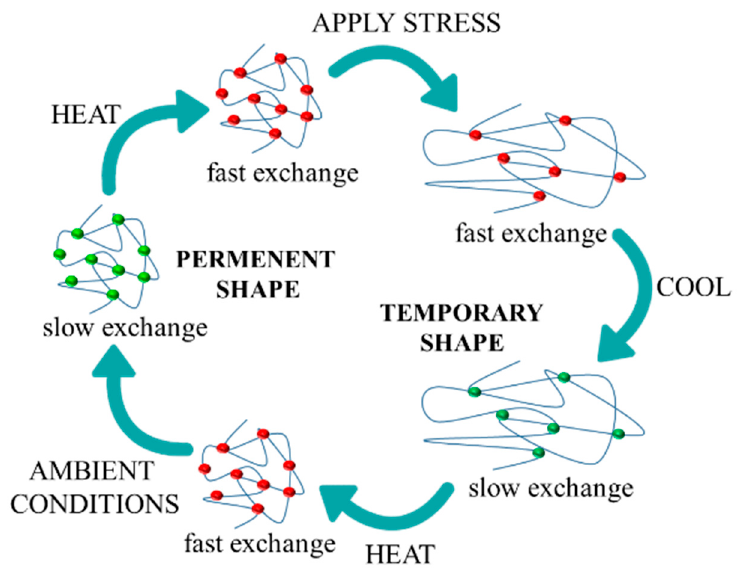
Figure 6. Schematic representation of shape-memory mechanism of our systems.